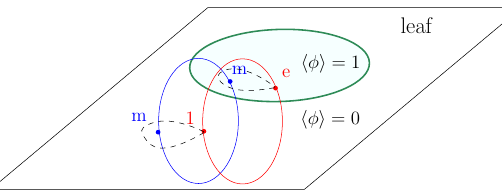
Figure 1: The three loop braiding process described by the correlation function (2.40), for N = N (cid:48) = 2. φ = 0,1 (white and light green) label the two vacua on the leaves of the (cid:90) two-form gauge theory on the leaves, separated by a domain 2 wall excitation (green string) which is confined to the leaves. The particles e , m are the electric and magnetic particles of the (cid:90) one-form gauge theory on the leaves. 2 The blue string consists of an m particle everywhere it intersects a leaf. The red string is a string that consists of an e particle excitation in the region φ = 1 and trivial parti- cles along the rest of the loop where φ = 0 (if the domain wall is only on a single leaf as drawn in the figure). The three-loop braiding comes from the braiding between e , m in the region φ =